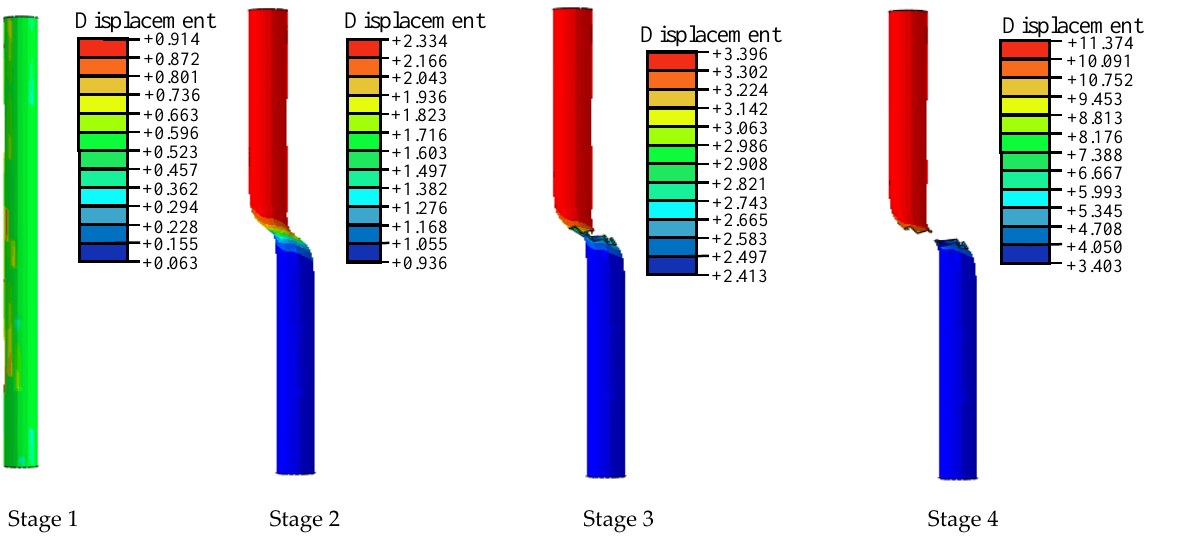
Figure 11. Displacement field distribution of the wellbore.